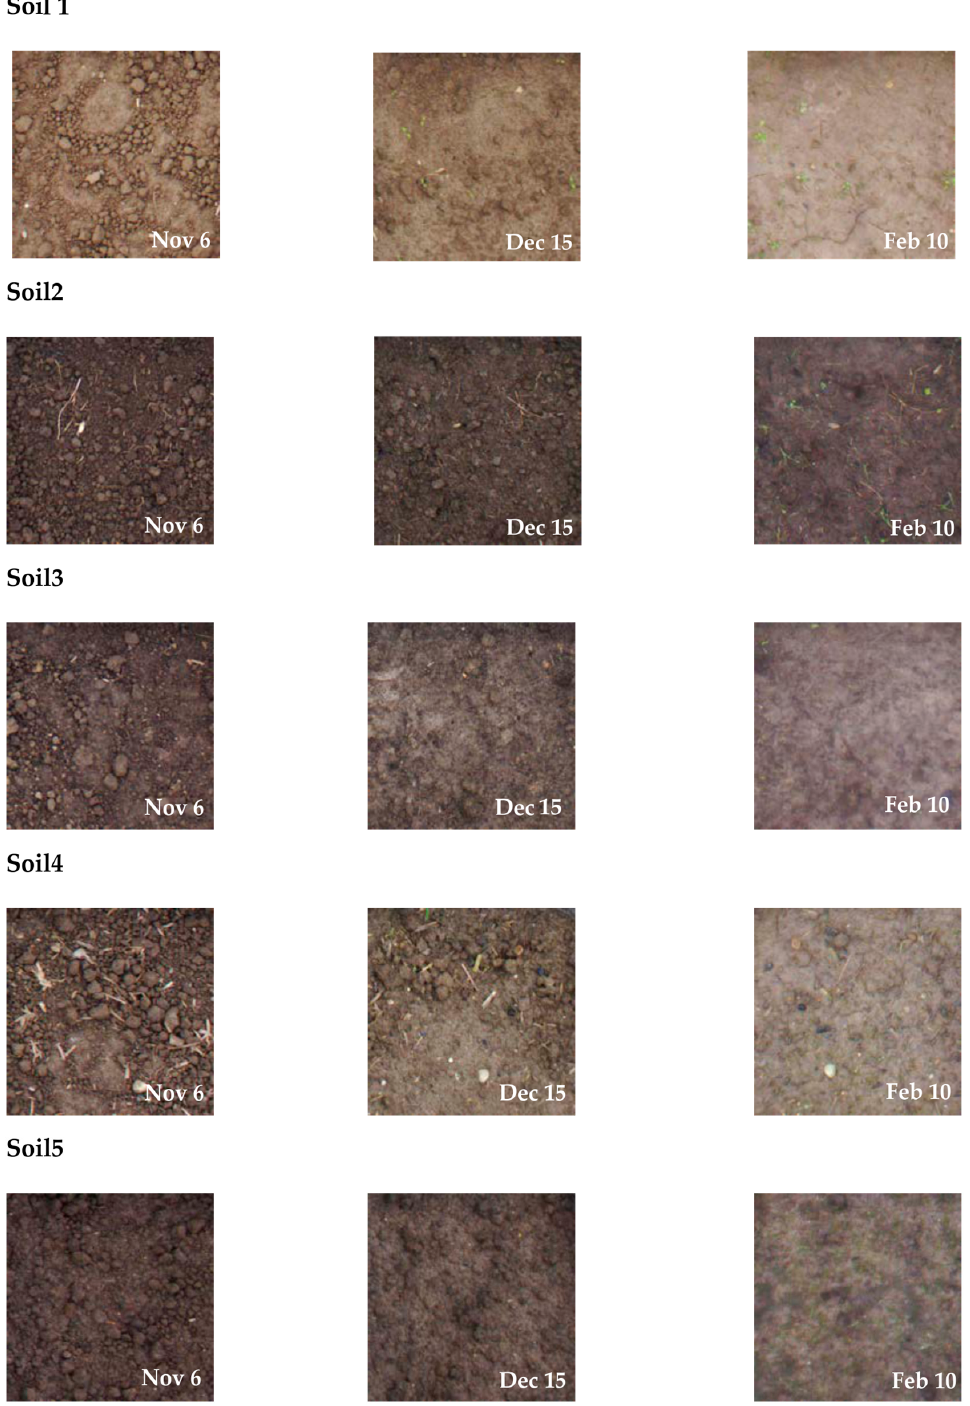
Figure 4. Original images for all soils at the beginning of the experiment (6 November 2014 images), after the first cycle of freezing–thawing followed by the biggest rain event (15 December 2014 images) and at the end of the experiment (10 February 2015 images). All soils experienced aggregate breakdown over time.